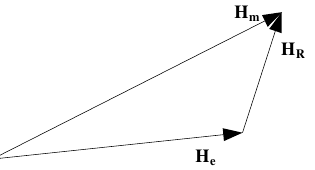
Figure 2. Vector relationship between total magnetic field, geomagnetic field, and disturbing magnetic field.